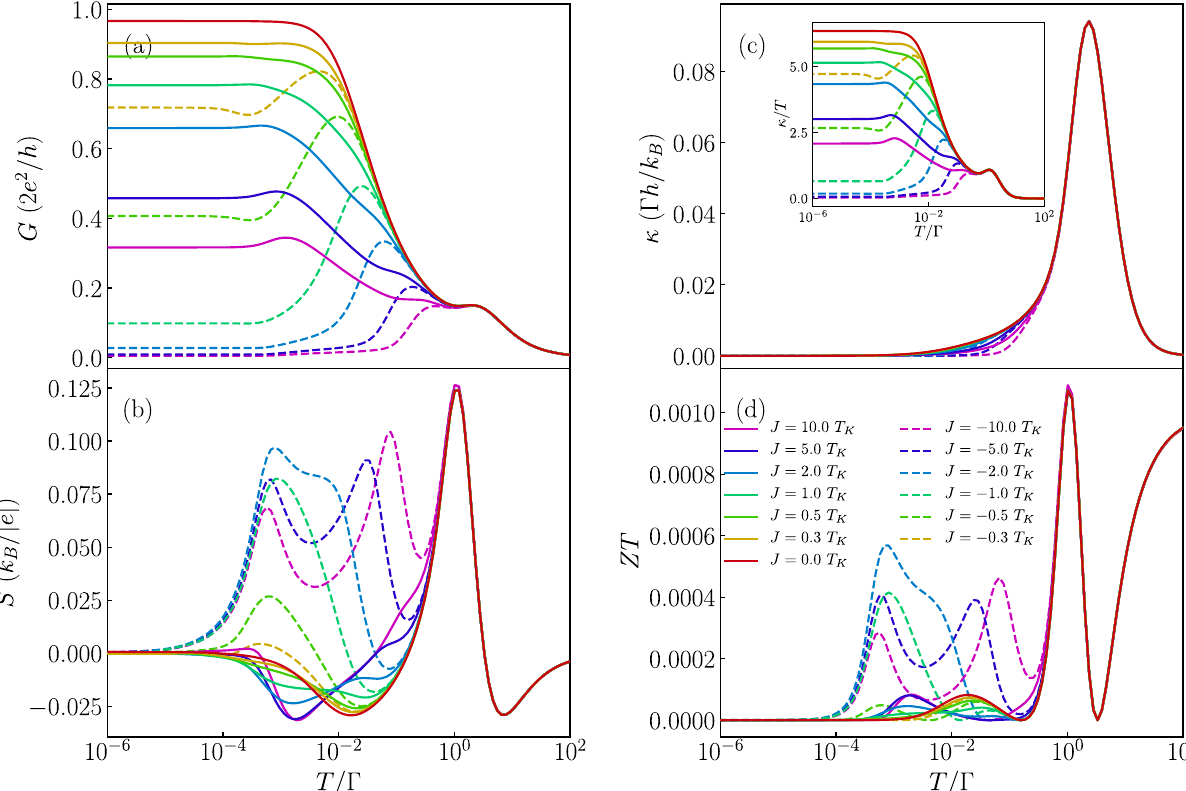
Figure 6. Dependence on exchange interaction in the case of ferromagnetic junction. ( a ) The conductance, ( b ) Seebeck coefficient, ( c ) heat conductance and ( d ) figure of merit as a function of temperature for selected values of exchange interaction J in the case of ferromagnetic leads. The solid (dashed) lines correspond to the case of ferromagnetic (antiferromagnetic) exchange interaction. The inset in ( c ) presents κ/ T as a function of temperature. The parameters are the same as in Fig. 5 with ε = − 0.48 U